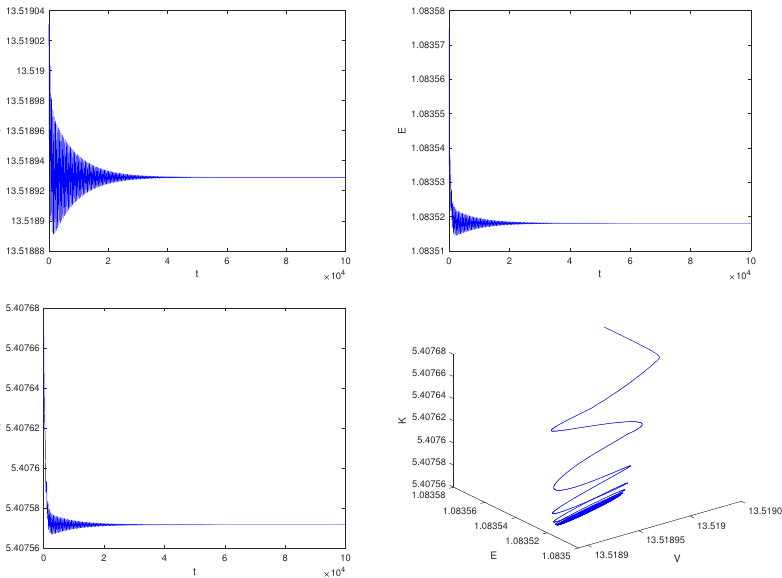
Figure 5. The phase graph and the trajectories of system ( 4 ) with τ 1 = 1.00, τ 2 = 4.50, S ∗ is stable again.